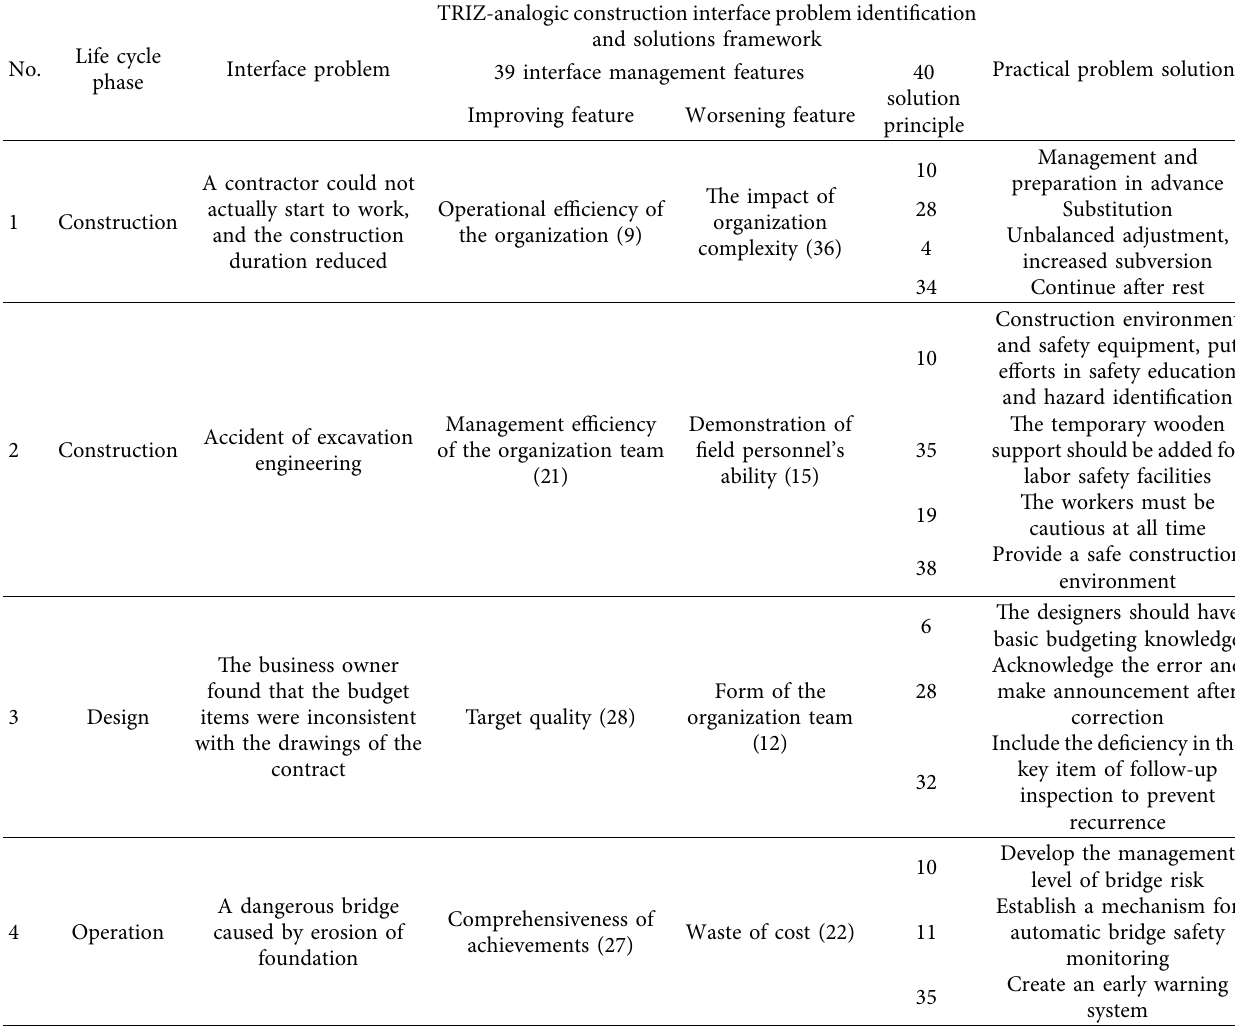
Table 10: Operations for the interface management contradiction matrix: case